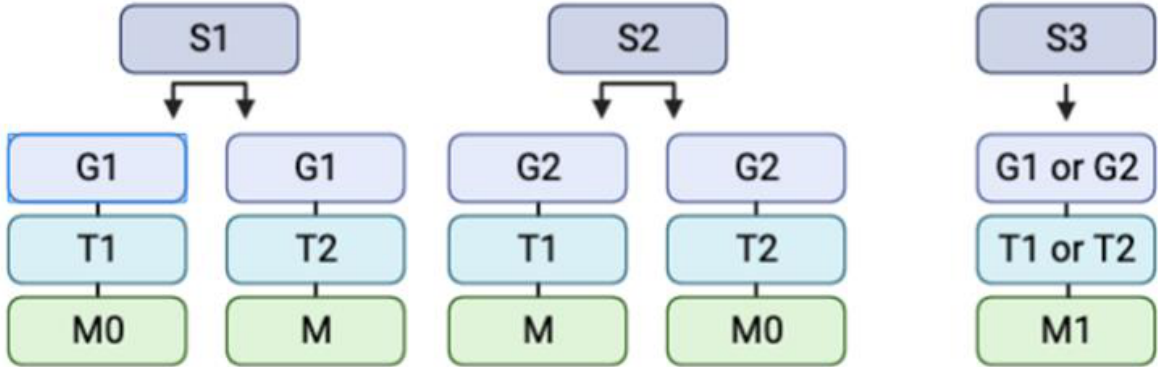
Figure 2. Illustrative depiction of a simplified Enneking classification system, which categorizes tumors into stage, grade, site, and presence of metastasis. The abbreviations are as follows: S = Stage